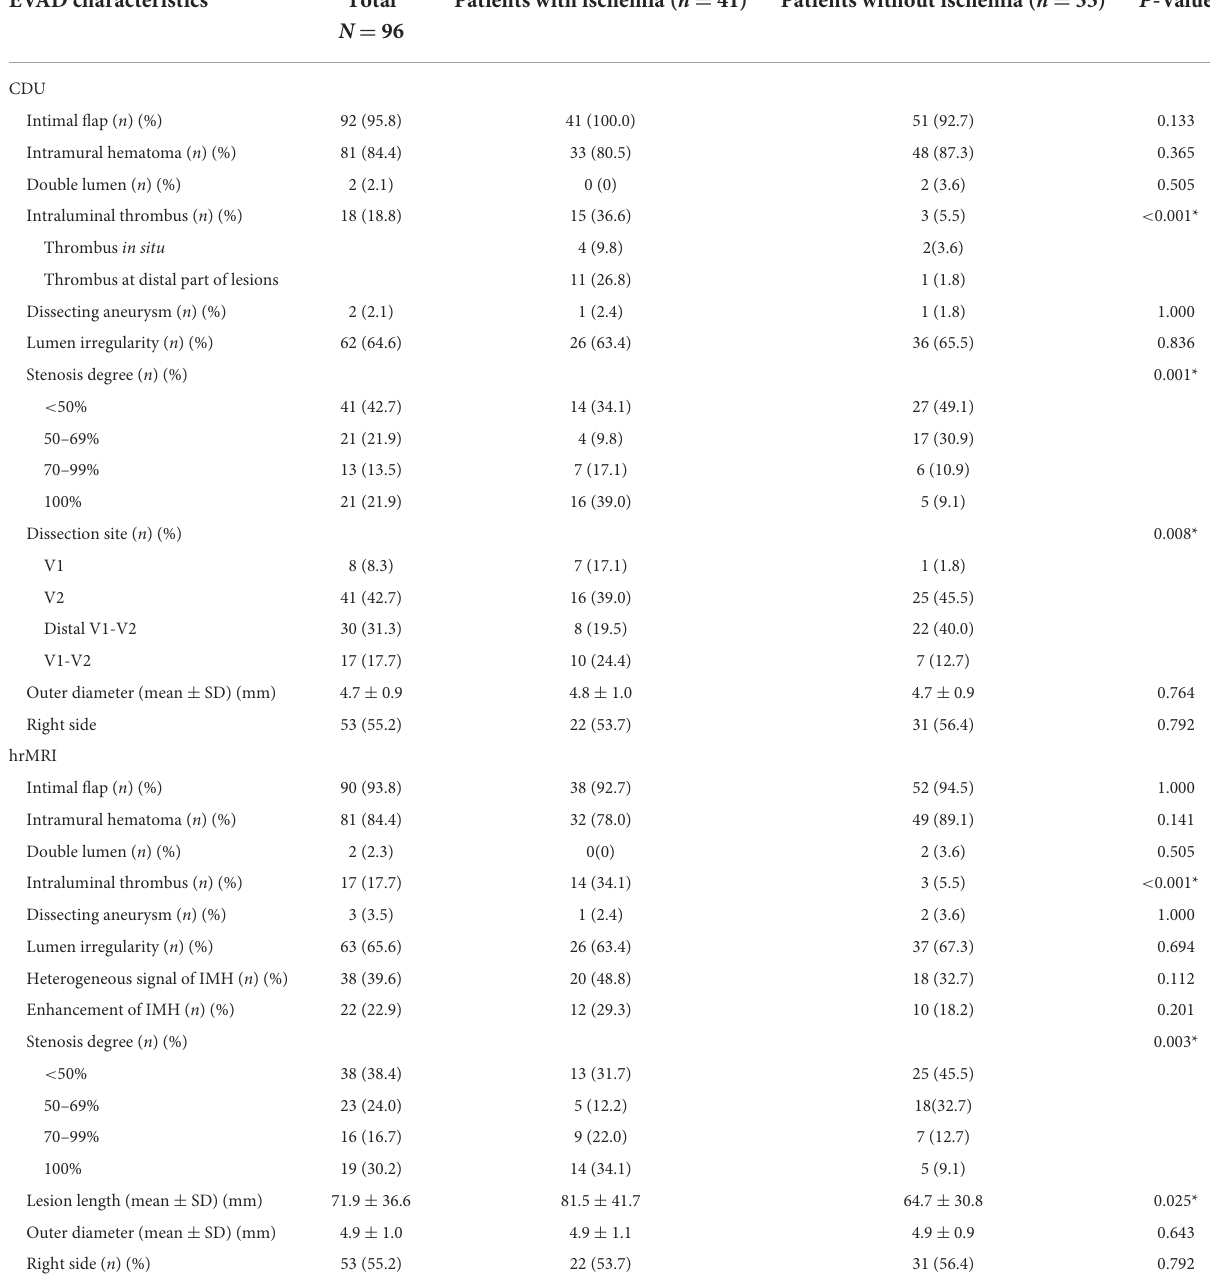
TABLE 2 Imaging features on CDU and hrMRI of EVAD patients with and without ischemia. EVAD